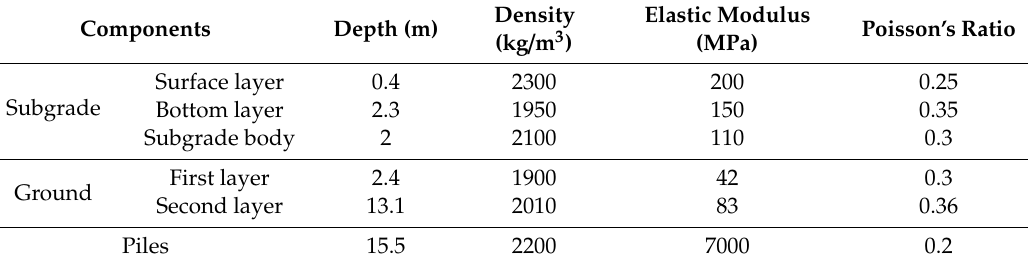
Table 2. Properties of the water. Table 3. Properties of multi-layered soils and piles.